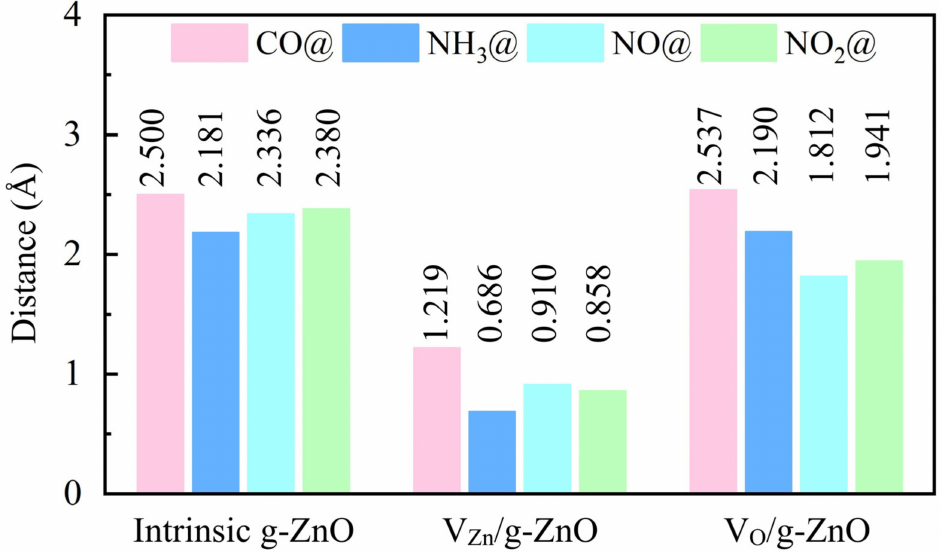
Figure 4. The absorption height of gas molecules on intrinsic g − ZnO, V Zn /g − ZnO, and V O /g − ZnO